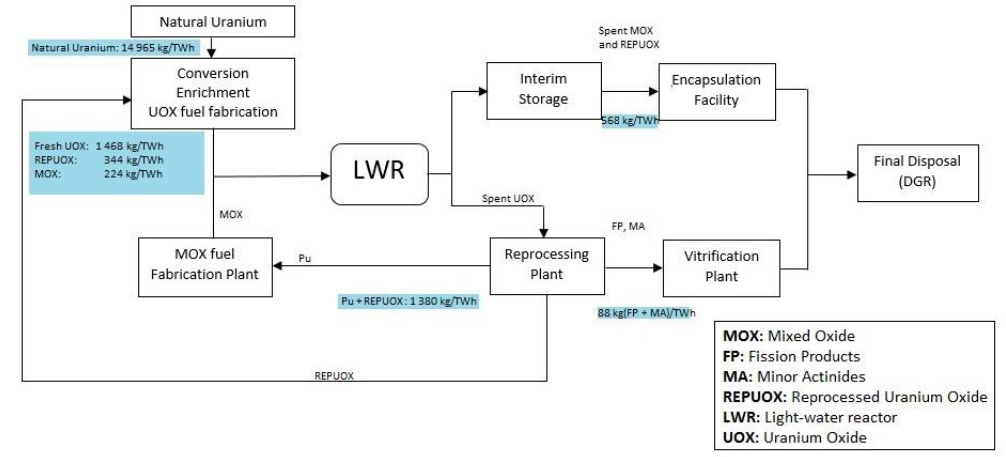
Figure 2. Partial recycling cycle. AFC (advanced fuel cycle): LWRs (Light-water reactors) and FRs (Fast reactors) are used in this strategy, so MOX and REPUOX fuels can be reprocessed and recycled again as fuel in FRs, closing the fuel cycle. A DGR will also be necessary to store the vitrified waste. This is shown in Figure 5.